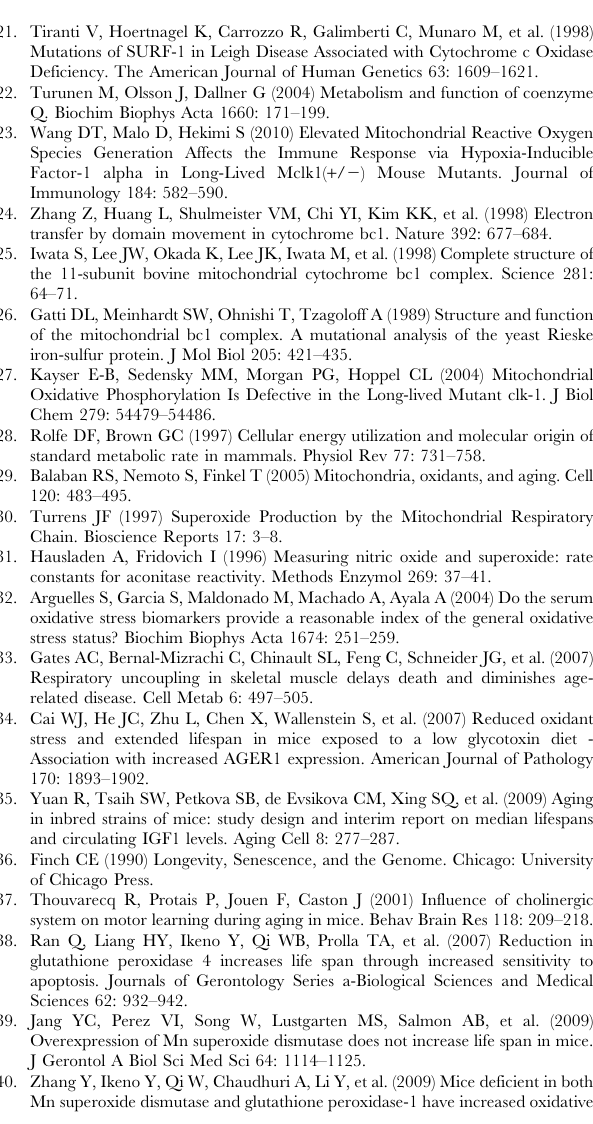
Table S1 Body and organ weights. Table S2 Exact values for Figures 1, 2, 3, 5, 6 and 7.